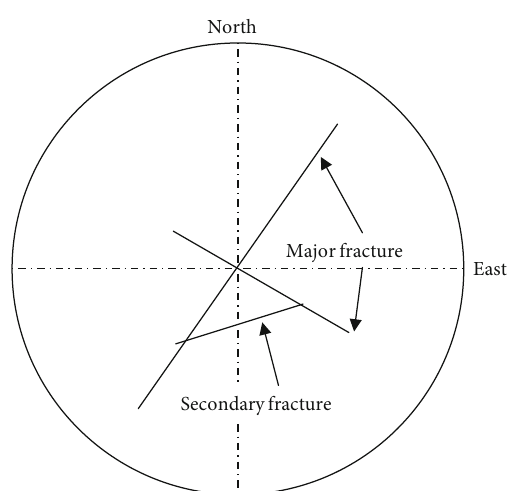
Figure 19: Sketch of fracture morphology based on microseismic crack monitoring.